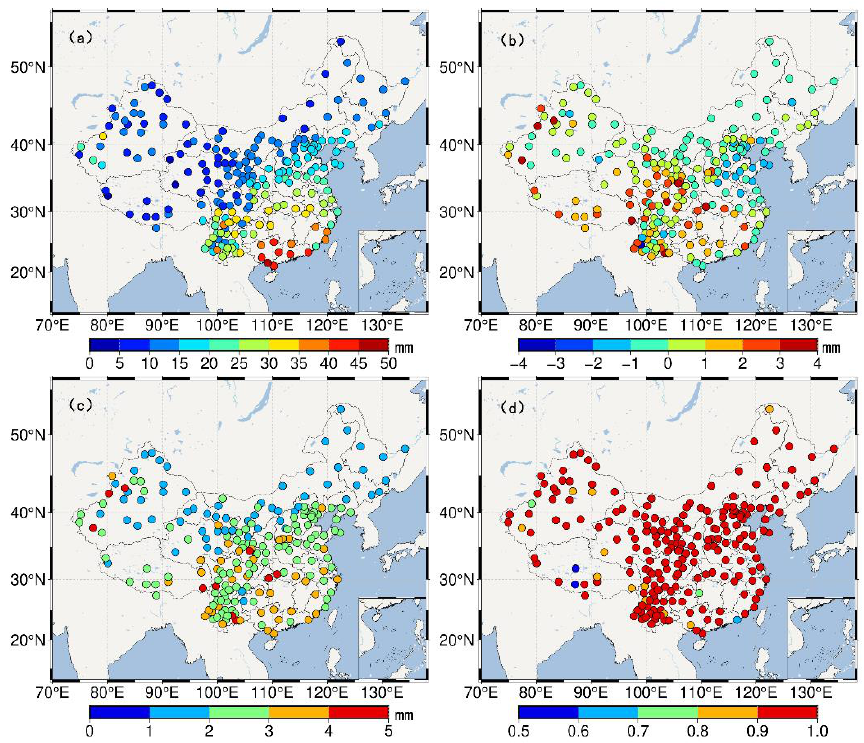
Figure 3. ( a ) Annual average PWV value at GNSS stations. ( b – d ) Bias, RMSE, and correlation between the GNSS PWV and ERA5 PWV, respectively.